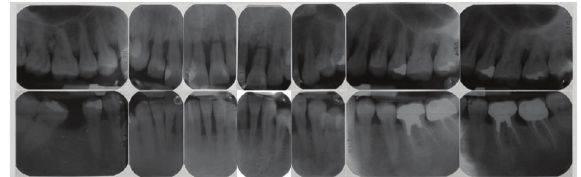
Figure 4: Intraoral periapical radiographs showing horizontal bone loss at all four maxillary incisors.